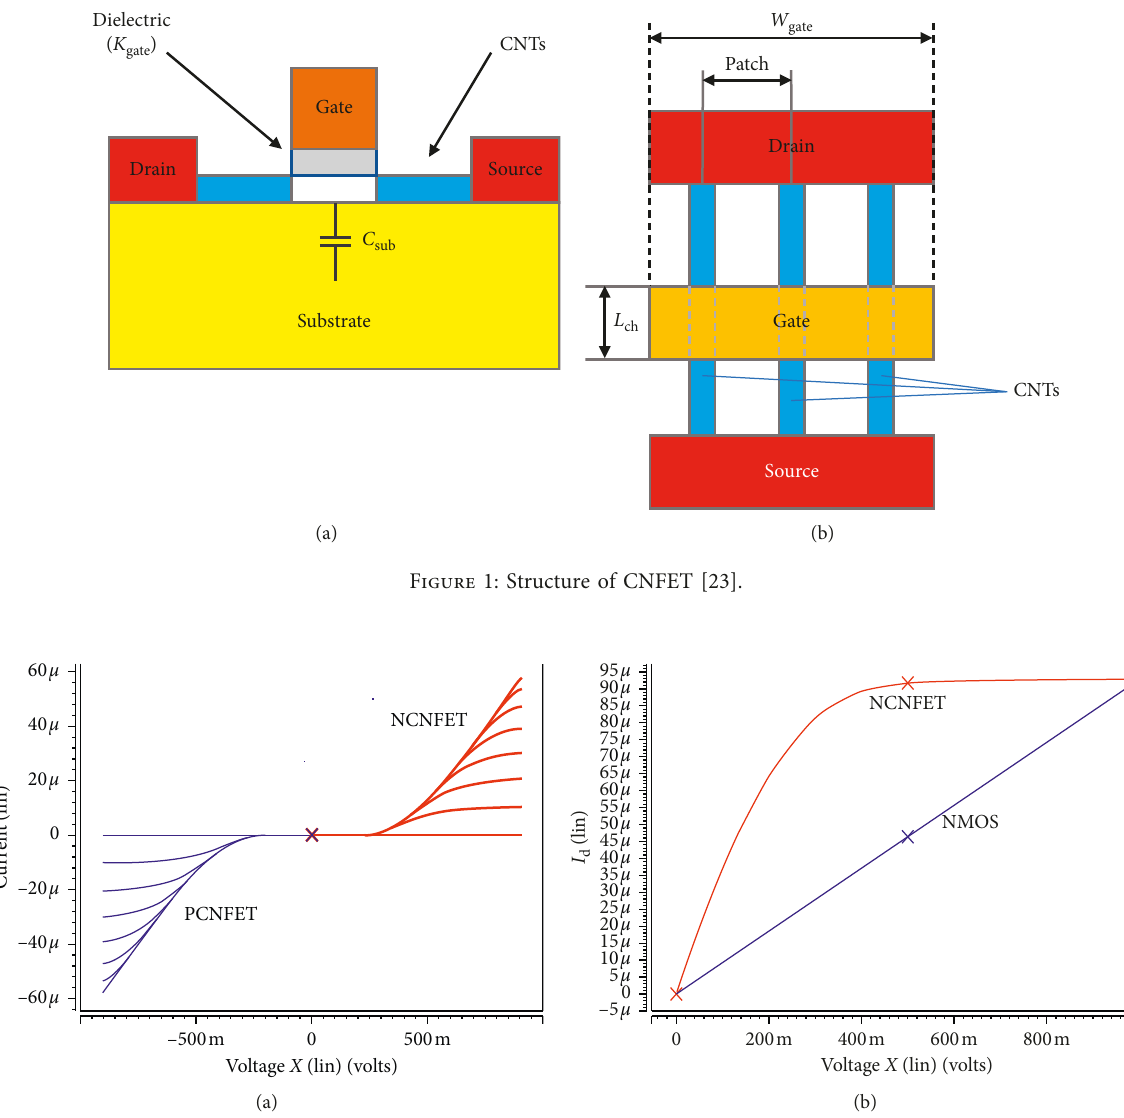
Figure 2: I - V characteristics of 32nm CNFET and CMOS. (a) I NCNFET and